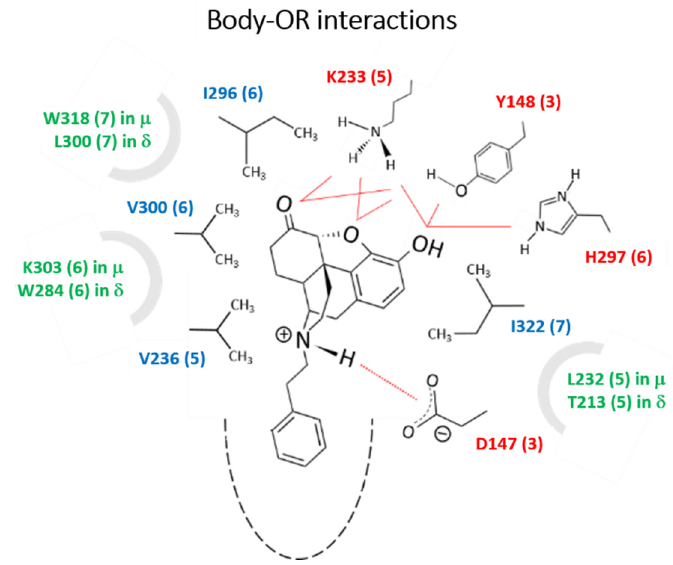
Figure 1. Conserved polar/charged residues (in red; numbering as in MOR) that interacted with the -O and -OH groups of the N -phenethylnorhydromorphone body through H-bonds; the body was also stabilized by close packing with four conserved nonpolar residues (blue) through hydrophobic forces. Although not in direct interactions, a few non-conserved residues (green) were seen to interact with the ligands indirectly through short water chains. These residues may thus be important to modulate the behavior of MOR and DOR independently, which may be accomplished through specific substituents that can engage them more directly. Frequencies of contacts were deemed statistically relevant if they were observed at least 25% of the time, except for the critical -NH---D147 distance (MOR) and -NH---D128 distance (DOR) that was required to persist for at least 75% of the time for the conformer to be considered (see details of the analysis in Table S2).